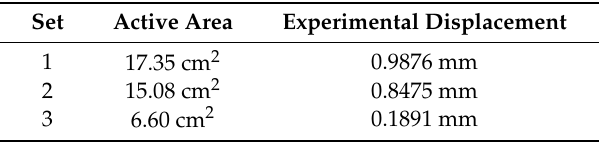
Table 6. Averaged Experimental Z -axis Displacement [23,26–29].